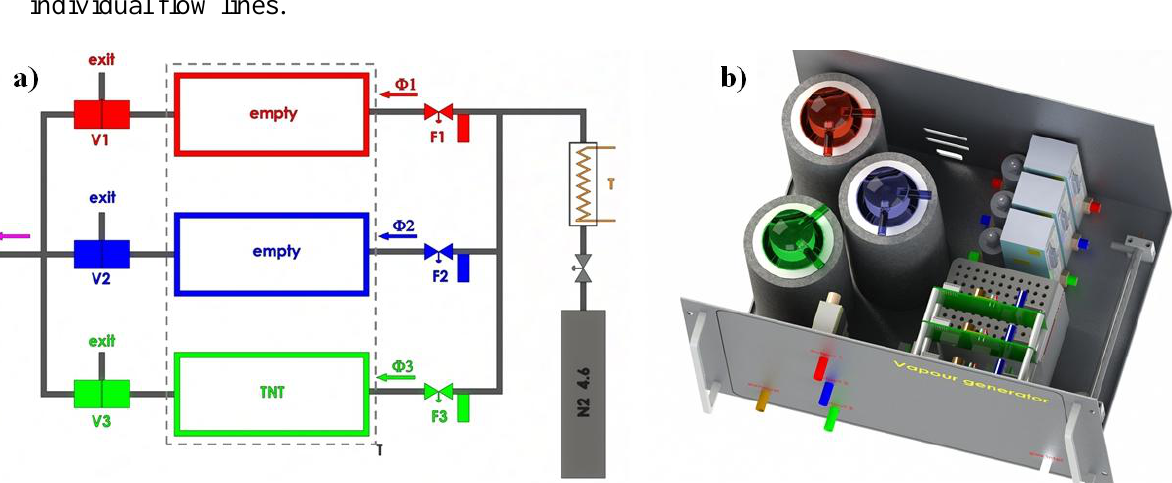
Figure 16. ( a ) Schematic diagram of the vapour generator. N gas from a storage tank is 2 thermally stabilized (T) and divided into three parallel flow lines (Φ1, Φ2, Φ3), each with electronic flow regulator (F1, F2, F3). The switching between the pure carrier gas and gas with the known concentration of the explosive’s vapour, while keeping the total mass flow constant, is done by mixing the gas from an empty glass cylinder (Φ1) with either pure gas (Φ2) or with saturated gas (Φ3). The mixing is controlled by three valves V1, V2 and V3. ( b ) A model of the actual vapor generator used in the experiments. Red, blue, and green colors represent individual flow